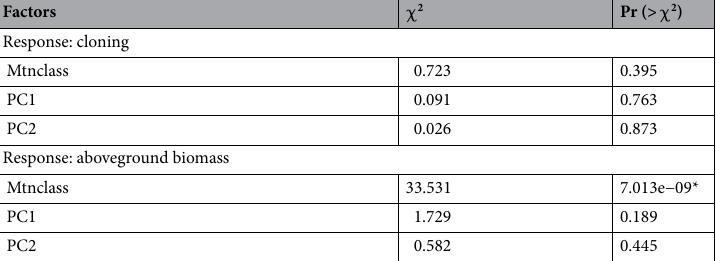
Table 2. Convergent trait variation is driven by natural selection for aboveground biomass and genetic drift for cloning. Data refer to summary statistics for mixed-effects models where cloning and aboveground biomass response variables were predicted by mountain class (“Mtnclass”: SI or MC) and microsatellite principal components axes (PC1 and PC2), with watershed/genotype as a nested random effect. Asterisks indicate differences that are significantly different from zero (* p <